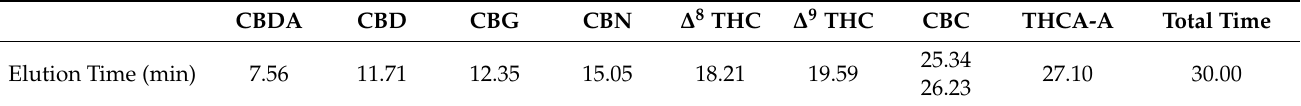
Figure 5. Ten-cannabinoid mixture separation under reversed-phase conditions with Chiralpak ID-U. Table 6. Elution times for 10-cannabinoid reversed-phase separation on Chiralpak